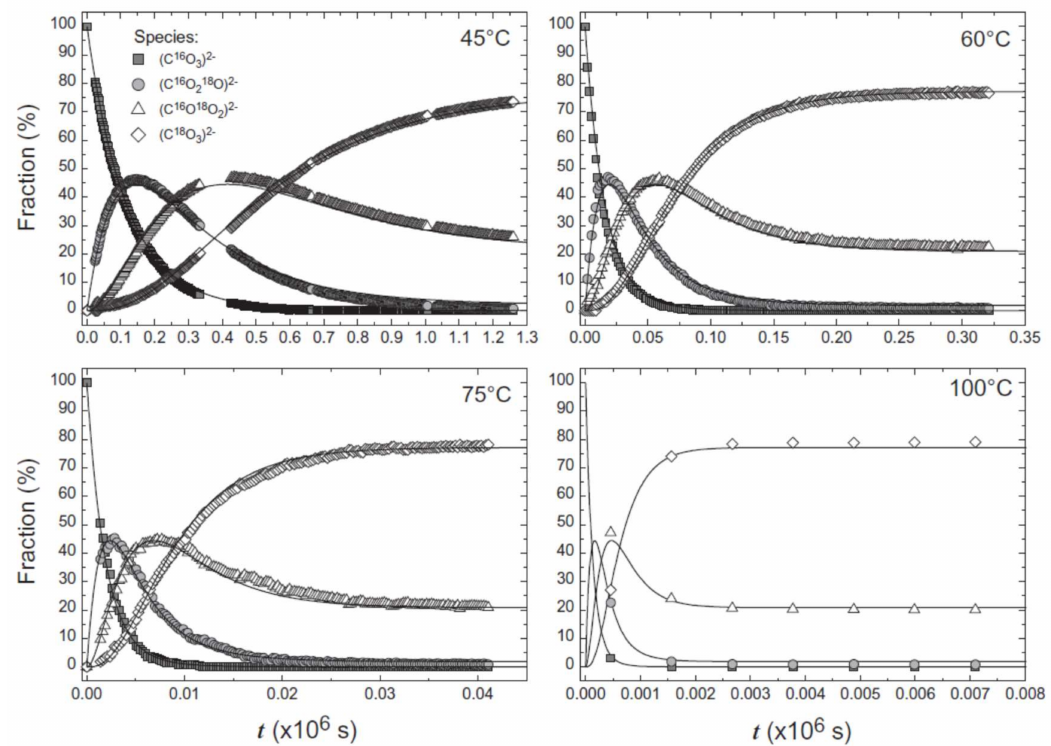
Figure 3. Fraction (%) of the different isotopologues of aqueous CO 32 − determined by in situ Raman spectroscopy as a function of reaction time between H 218 O and C 16 O 32 − , shown in Figure 2, at different temperatures. Reprinted from Geochimica et Cosmochimica Acta, vol. 90, Geisler et